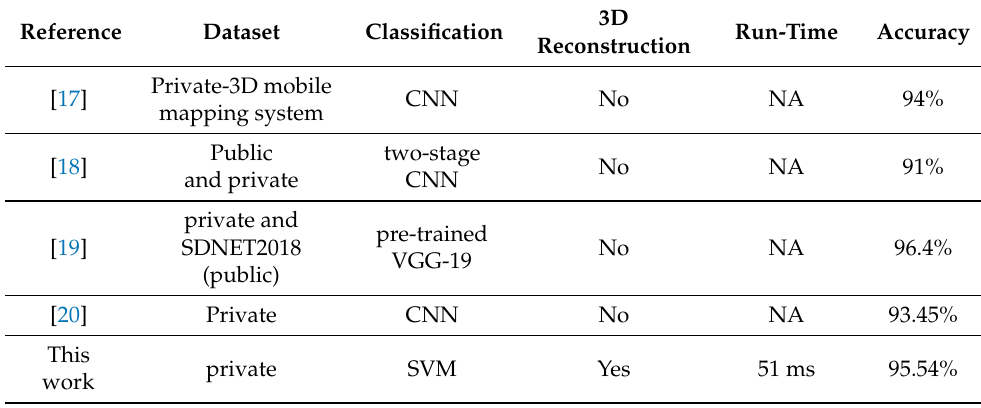
Figure 20. Recognition rate for each class of crack. Table 7. Comparison with recent